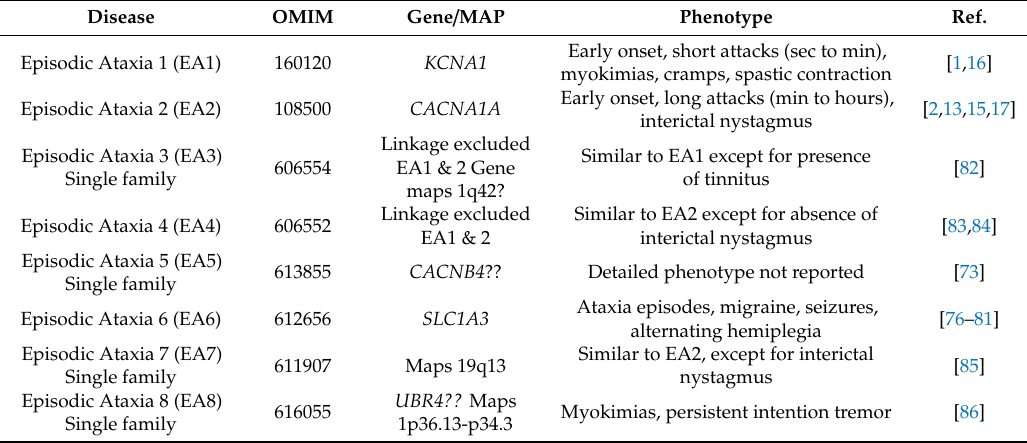
Table 1. List of Episodic Ataxias (EA1–EA8), all with an autosomal dominant inheritance. Disease OMIM Gene / MAP Phenotype